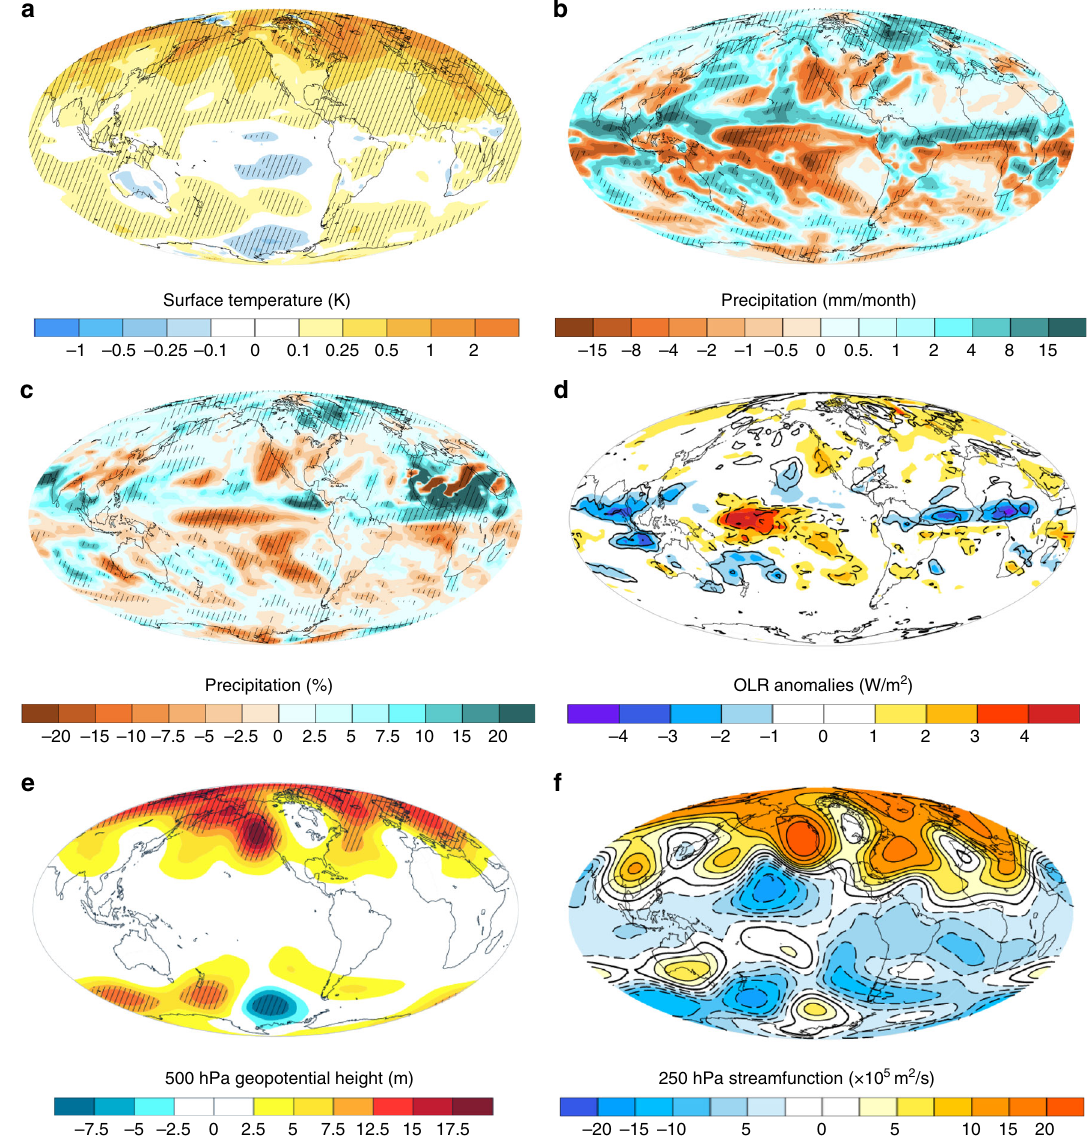
Fig. 2 Atmospheric impacts of Arctic sea-ice loss. Shown are the ensemble mean differences ( “ low Arctic ice ” minus control) for December – February (DJF) season. Stippling indicates anomalies that are statistically signi fi cant at the 90% con fi dence level. a Surface temperature anomalies. b Precipitation anomalies (absolute). c Precipitation anomalies (relative). d Outgoing longwave radiation (OLR) anomalies (shading) and the high cloud cover anomalies (contours). e 500 hPa geopotential distribution changes. f Stream function changes. Negative cloud cover anomalies in d are indicated with dashed